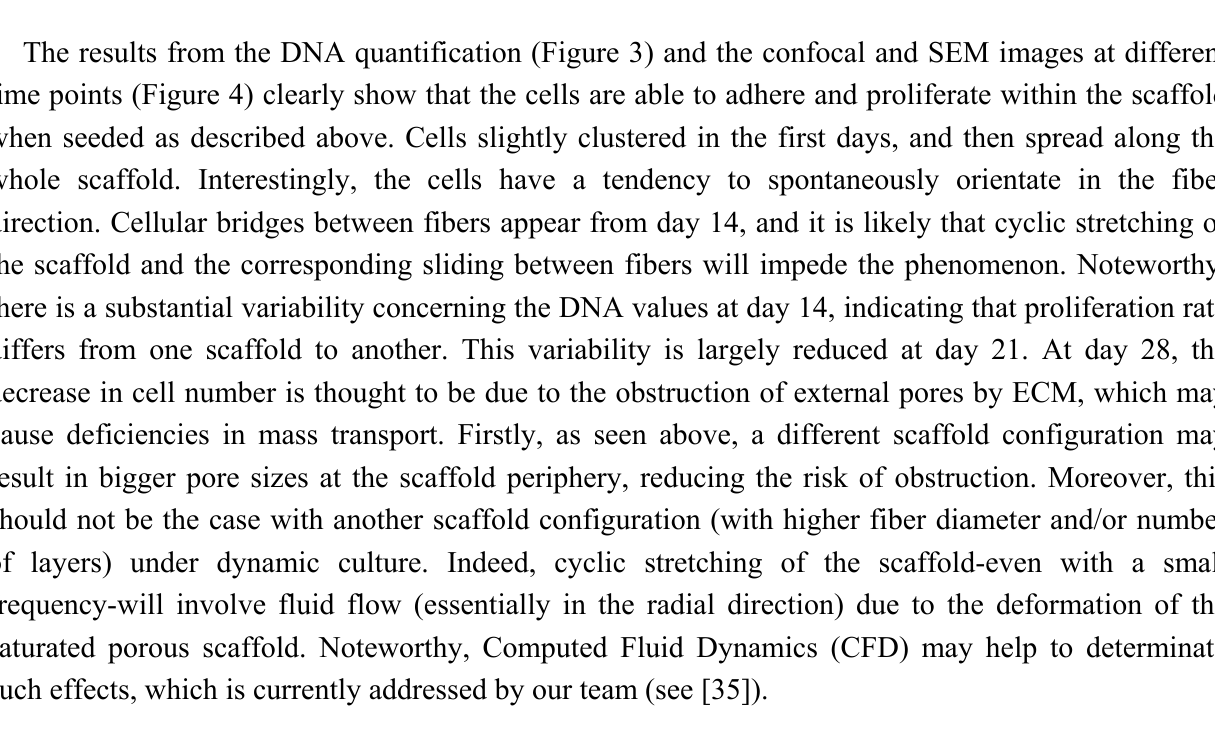
Figure 3. Evolution of DNA from 3 (D3) to 28 (D28)